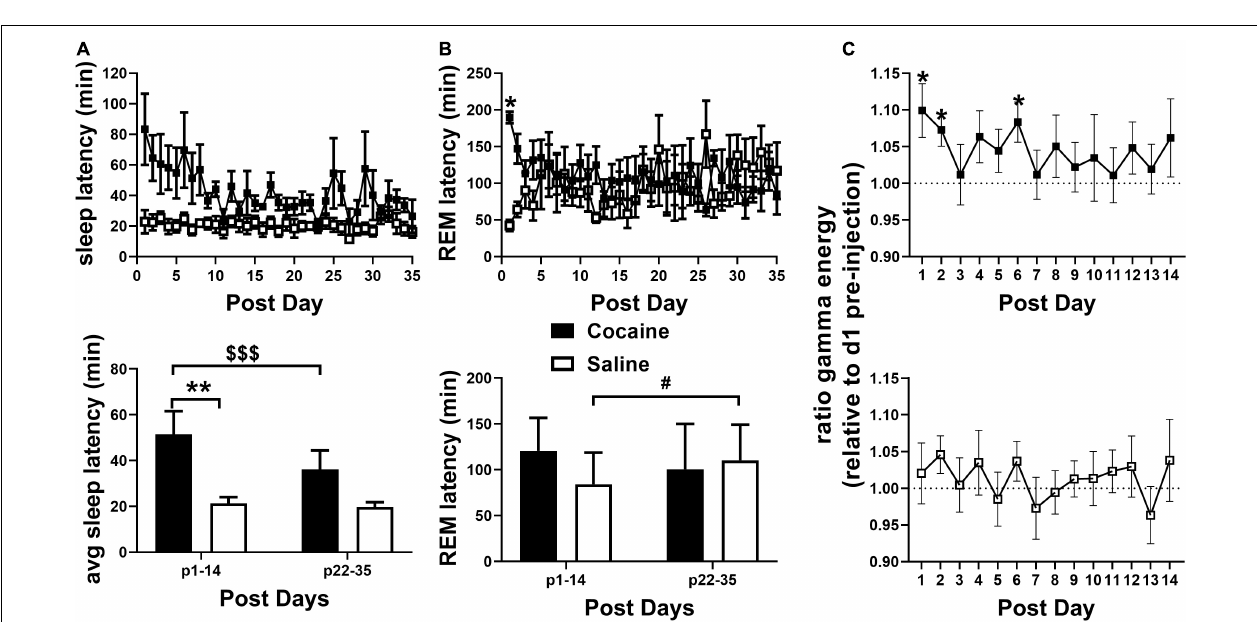
FIGURE 3 | ( A , top) SL remained elevated in the cocaine group compared to the saline group during the 35 days post-injection/forced abstinence period. ( A , bottom) Average SL following handling/weighing remained higher in cocaine-experienced animals during the first 2 weeks compared to saline experienced animals throughout abstinence and compared to cocaine experienced animals in the latter portion of the post-injection/forced abstinence phase. ( B , top) REML remained higher in cocaine-experienced animals on the first post-injection day only. Cocaine n = 6 (one mouse missing values days p21–35), saline n = 6. ( B , bottom) Average REML did not vary between groups during the first two and last two post-injection/forced abstinence weeks, though saline-treated animals showed a non-significant trend toward increased REML across the post-injection/forced abstinence period, cocaine n = 5–6 (one mouse not included in p22–25 average), saline n = 6. (C) During the post-injection/forced abstinence phase relative gamma energy (ratio to pre-injection waking gamma energy) increased in the cocaine group (top) over several days of the first post-injection week, while waking gamma energy was unchanged in saline-experienced animals (bottom). Cocaine n = 5–6 (one mouse missing days 22–35), saline n = 6. Asterisks indicate a significant difference between groups (A,B) or from 1 on specific days [pre-injection gamma energy (C) ], dollar signs and pound signs indicate a significant and non-significant trend toward a difference between time points with lines indicate the columns compared. P and F values are given in Table 1 and statistics for all pairwise comparisons with significant difference or trends toward significance are given in Supplementary Table 1 .